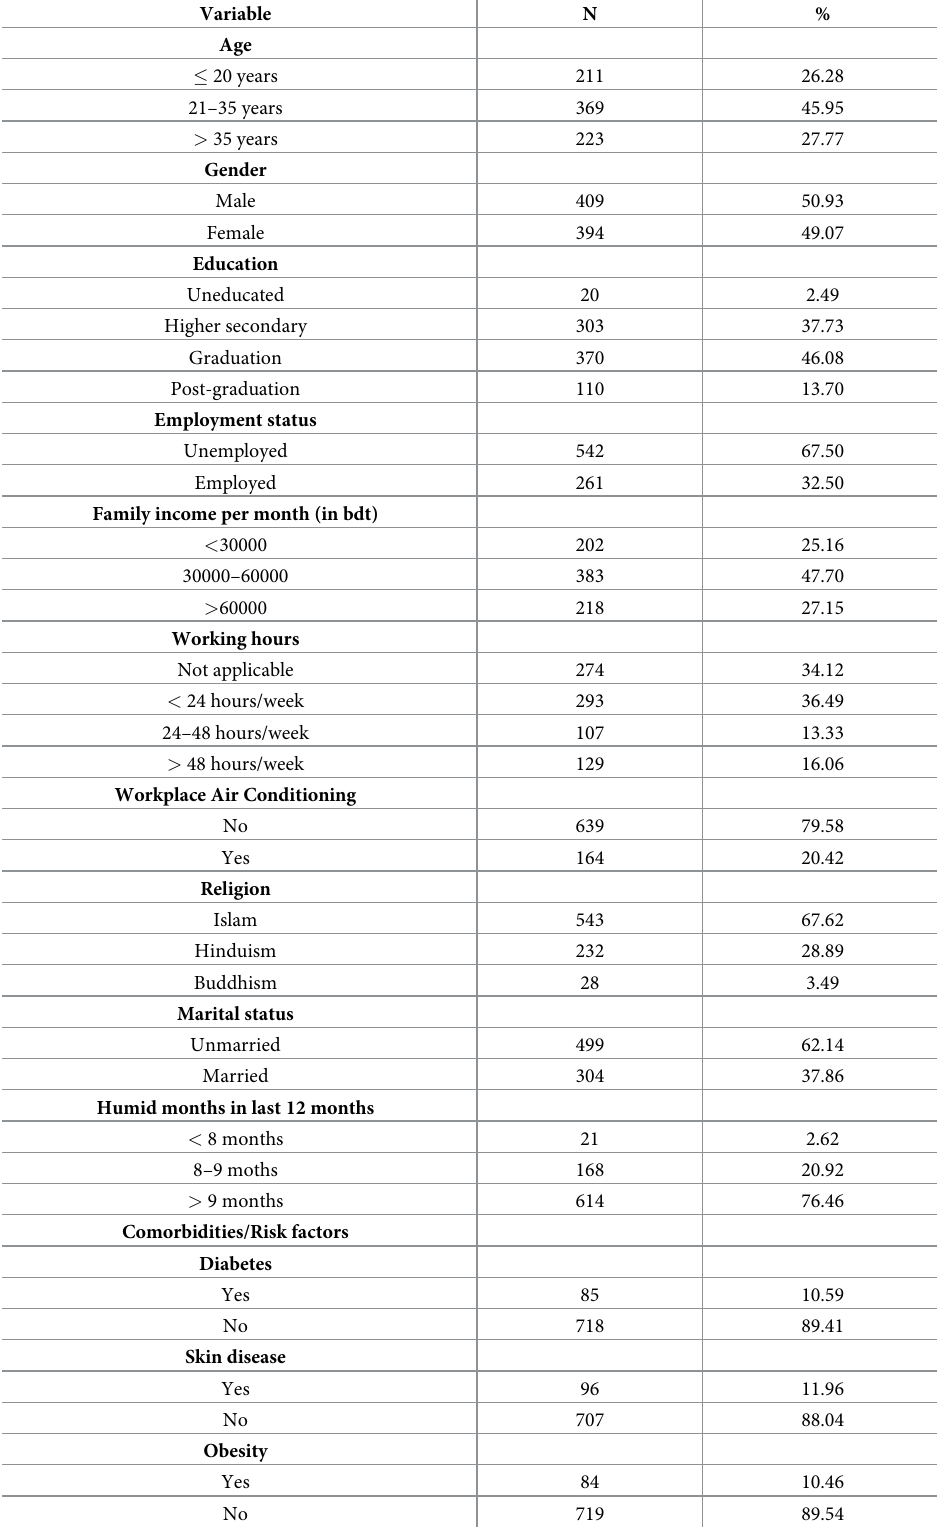
Table 1. Descriptive characteristics of the study participants (N =